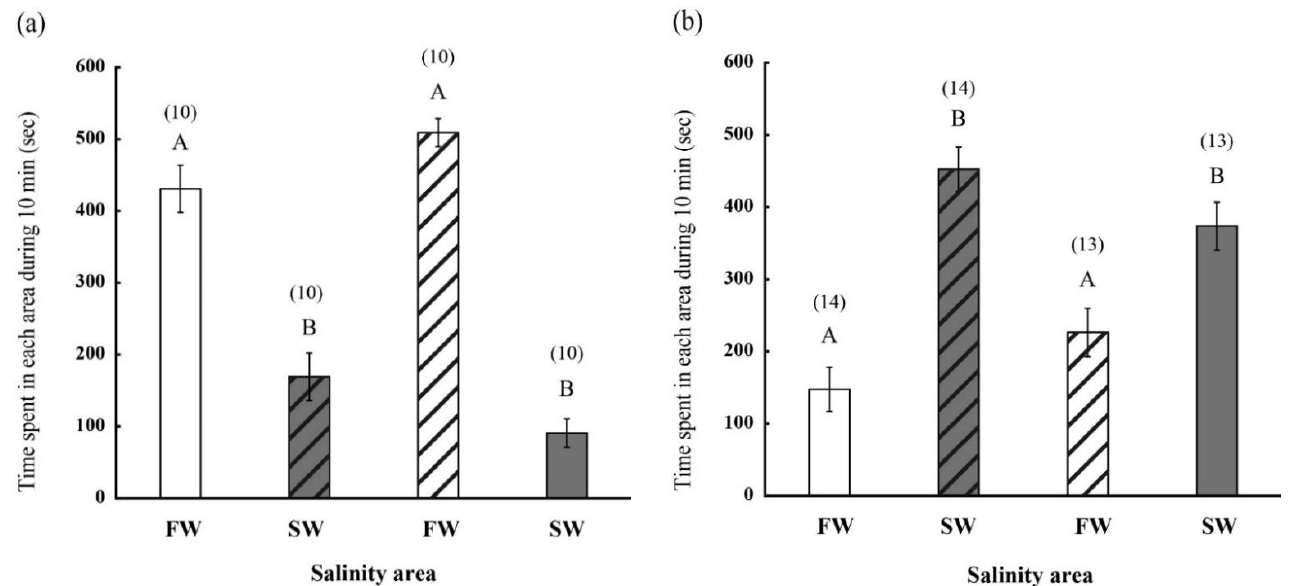
Figure 3. Time in each salinity area (FW or SW) during 10 min in FW-acclimated medakas ( a ) and SW-acclimated medakas ( b ). The experiment was repeated using two aquarium environments: one set is colorless FW (white bar) and blue-colored SW (grey and diagonal bar), and the other set is blue-colored FW (white and diagonal bar) and colorless SW (grey bar). Numerals in parentheses indicate the number of fish examined. Data are expressed as means ± SEM. Different letters indicate significant differences within the same group (Steel–Dwass multiple-comparison test, p < 0.05).